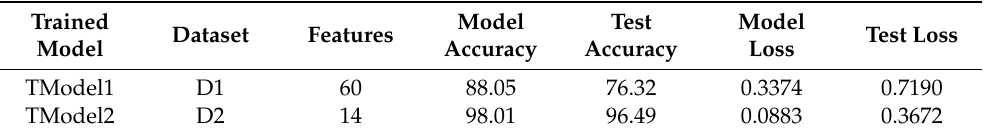
Table 13. TensorFlow Model Evaluation.